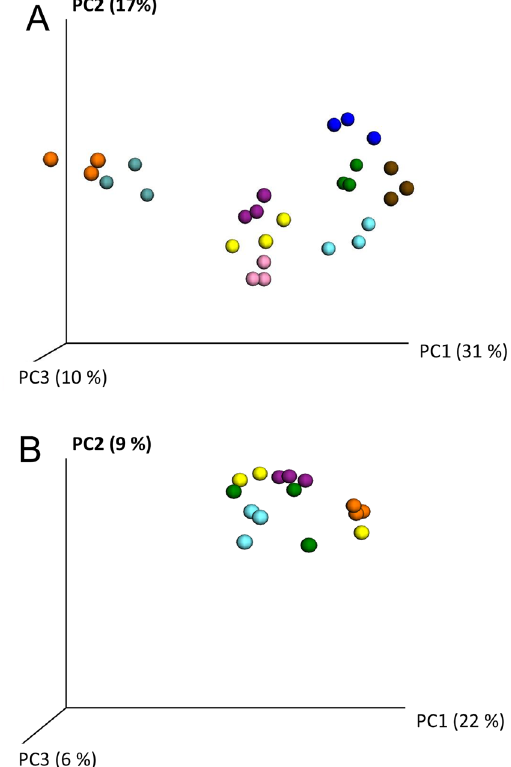
Figure 6. Reproducibility of Illumina Miseq sequencing of saliva samples. PCoA plots of ( A ) same samples run in triplicate, and ( B ) three independent samples collected from five subjects every second day during a week. Same colour indicates same sample or